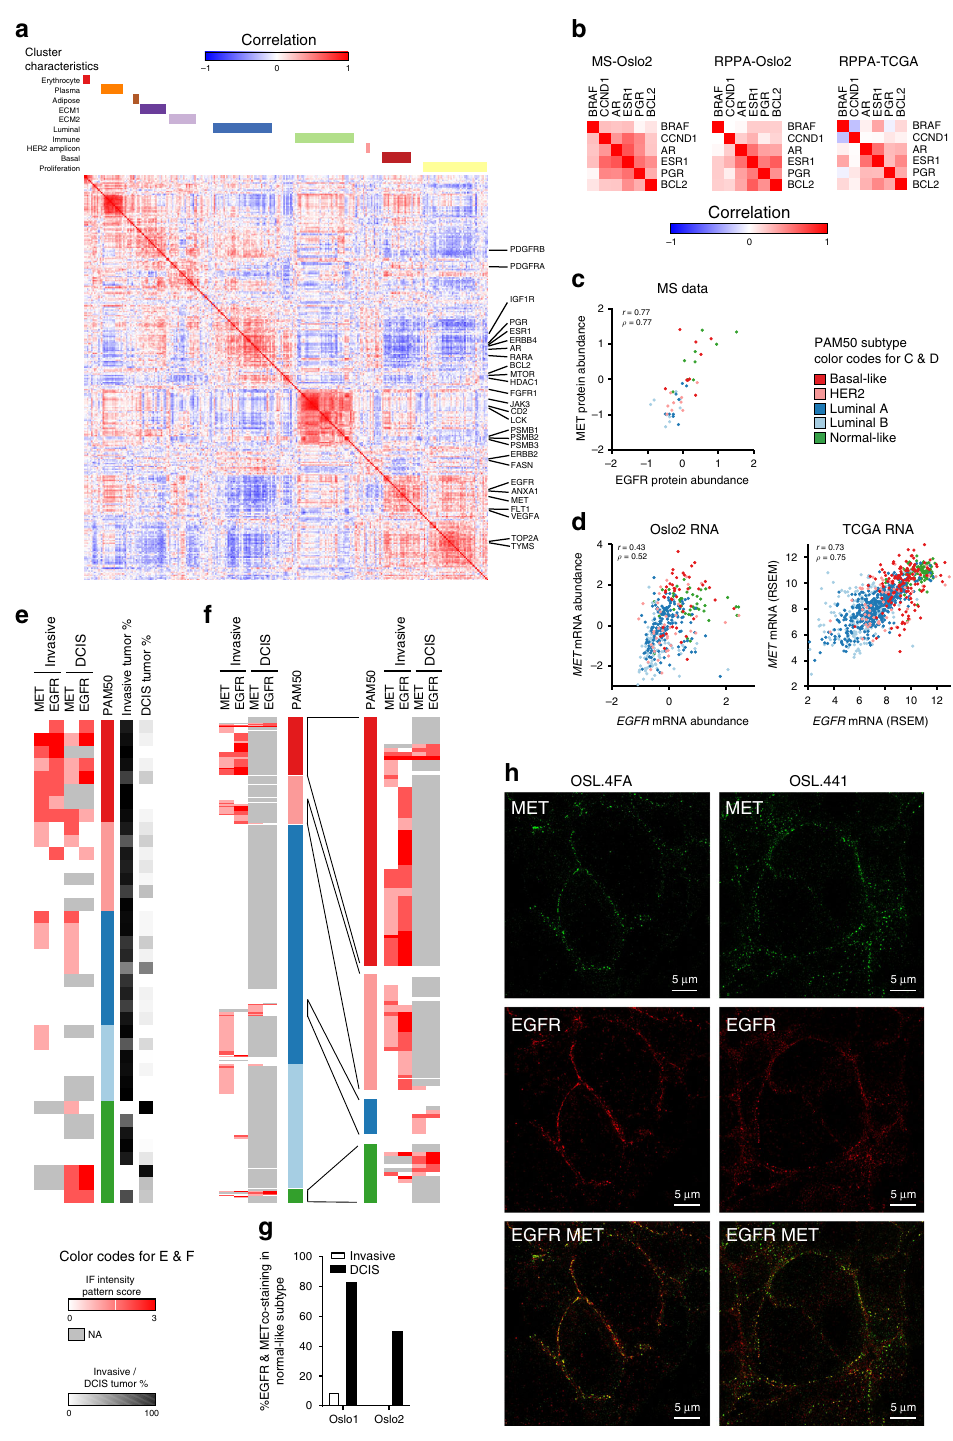
Fig. 4 Druggable proteome analysis. a Correlation matrix of all 290 FDA approved drug targets detected and quanti fi ed across all 45 tumors. Top panel shows the connection to annotated protein clusters de fi ned in Fig. 2a, Supplementary Fig. 2. Selected BC targets and potential targets, highlighted on the right side. b Correlation matrices, comparing MS data, and antibody-based quanti fi cation (RPPA), from Oslo2 ( n = 329) and TCGA ( n = 892), for correlating luminal drug targets from a identi fi ed in all three datasets. c Scatter plot of EGFR and MET protein levels in Oslo2 MS data. d Scatter plot of EGFR and MET mRNA levels in the whole Oslo2 cohort ( n = 378) and TCGA ( n = 950). Correlation coef fi cients are indicated as Pearson ’ s r and Spearman ’ s ρ in c and d . e Scoring of EGFR and MET IF staining pattern from whole sections of 40 of the Oslo2 tumors analyzed by MS proteomics. Tumors are arranged according to PAM50 subtype and separated by invasive and ductal carcinoma in situ (DCIS) tumor regions. See Supplementary Fig. 9 for staining examples. f Scoring of IF staining pattern from Oslo1 cohort ( n = 530) in the same way as in e . g Co-staining of EGFR and MET in the normal- like subtype. Evaluable DCIS and invasive components from e and f are shown. h Super-resolution STED microscopy of EGFR and MET staining in in situ regions of two normal-like